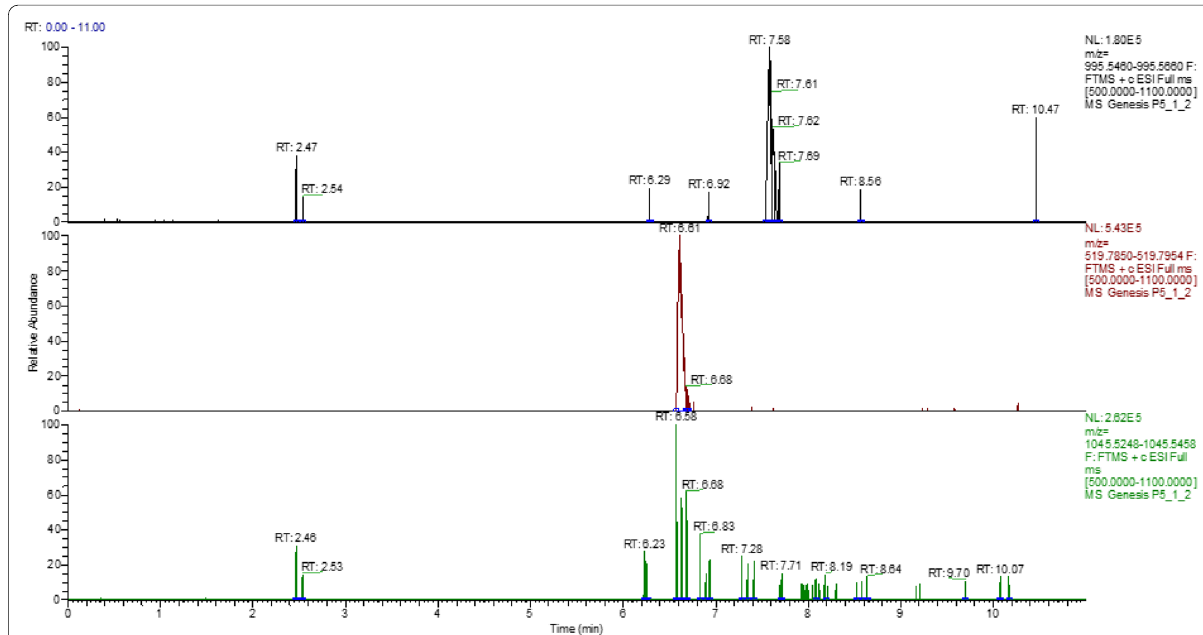
Fig. 4 Chromatogram of farmed mussel near the estuaries of Delta of Axios river. Retention time of microcystin-LR is 7.58 min and of microcystin-RR 6.61 min